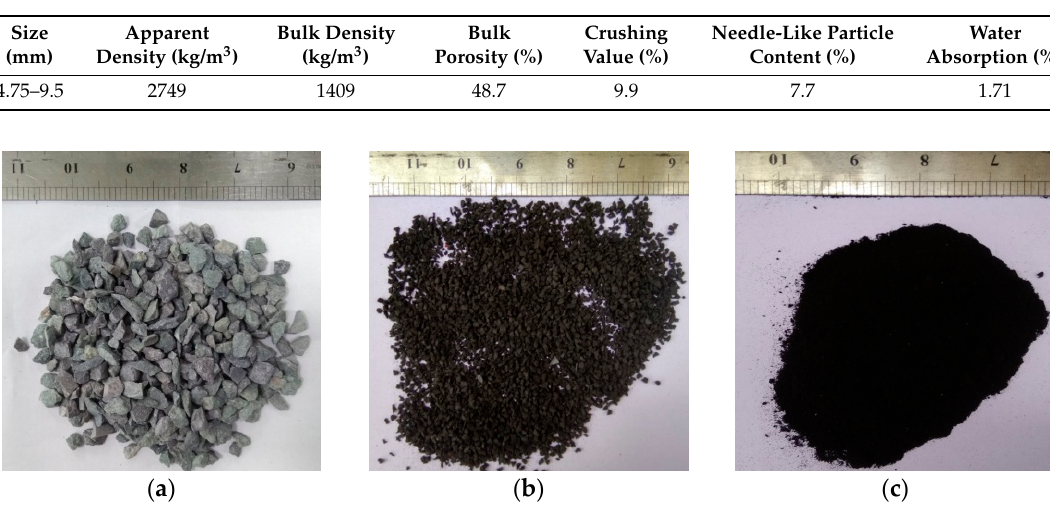
Table 3. Properties of natural granite coarse aggregate.